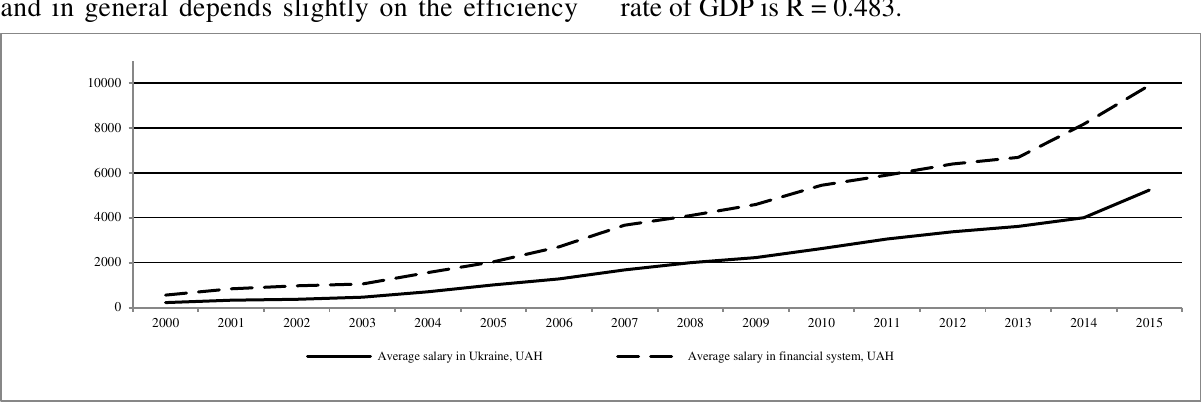
Fig. 5. Comparing flow of an average salary in the financial